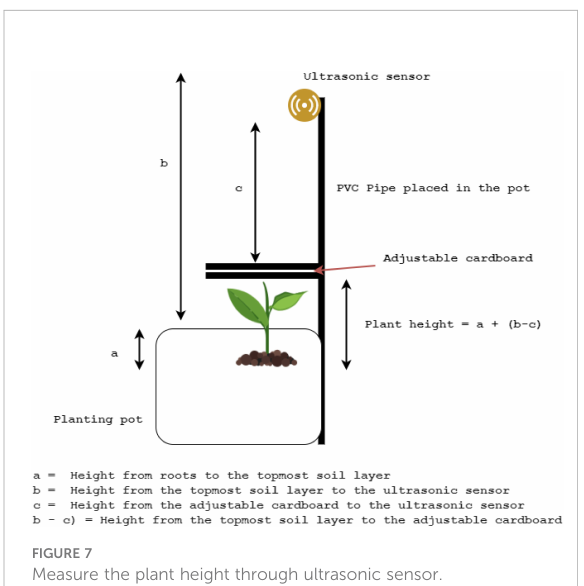
FIGURE 7 Measure the plant height through ultrasonic